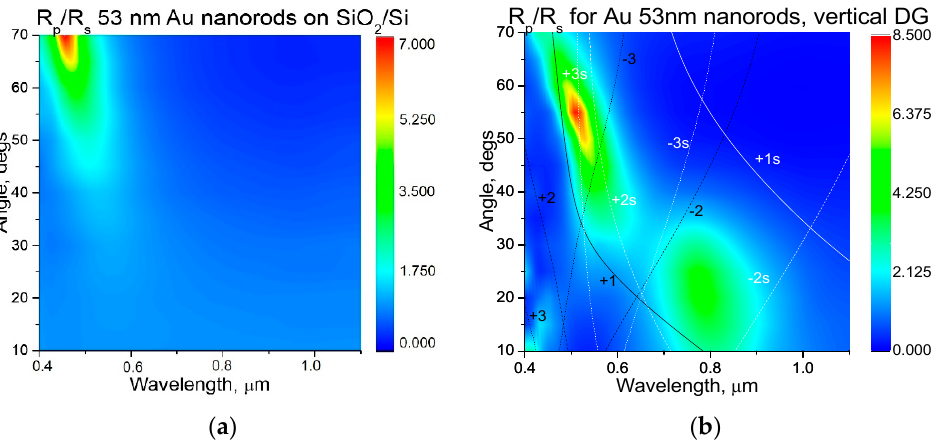
Figure 6. Comparison between samples with 13 nm Au NPs on oxidized flat Si ( a ) and on oxidized Si with vertically aligned diffraction grating (DG) ( b ). Dispersion curves ( b ) for surface plasmon-polariton waves for two boundaries, air/gold (±1, 2, and 3) and gold/silica (±1s, 2s, and 3s), are shown for different diffraction orders 1, 2, and 3 (shown on the figures).